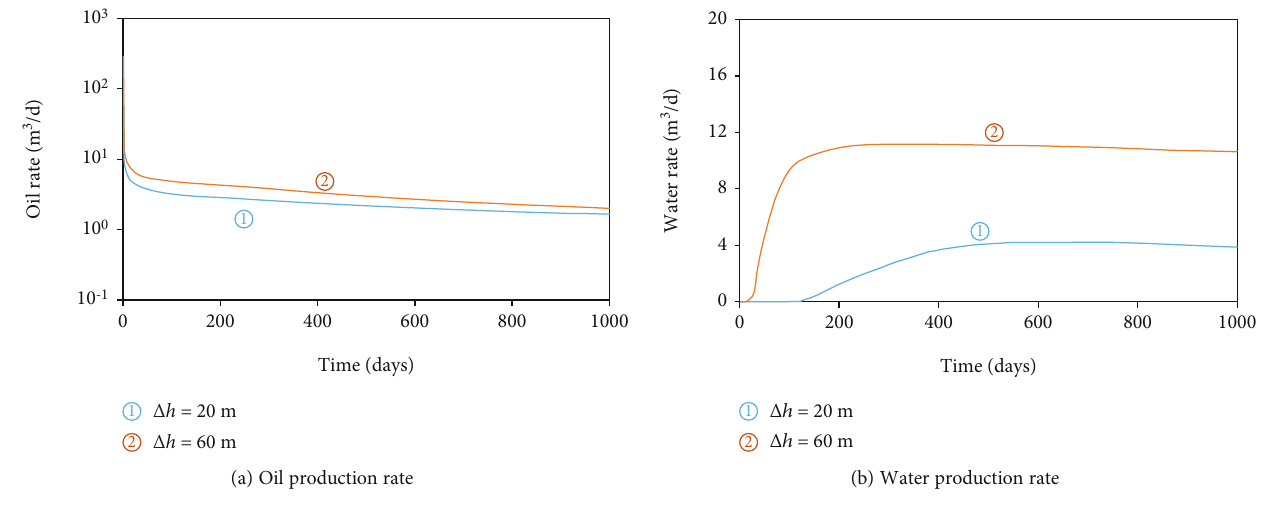
Figure 11: E ff ect of the perforation position on oil and water production